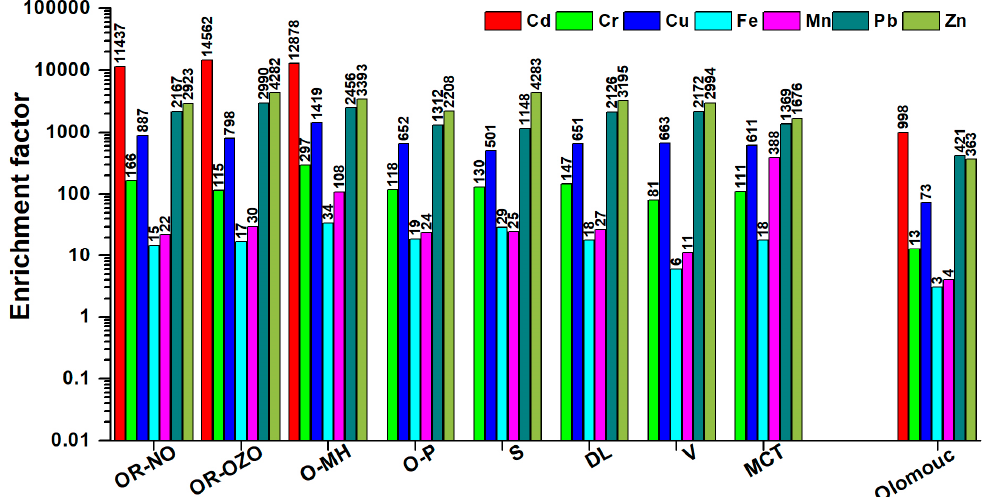
Figure 5. Enrichment factor for trace elements—comparison with Olomouc in the period with acceptable pollution.